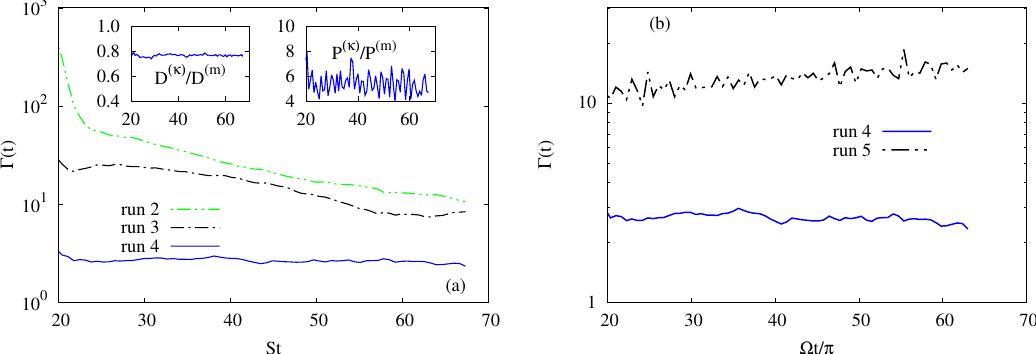
Figure 5. ( a ) Time development of Alfvén ratio Γ = E ( κ ) / E ( m ) in the PMHDT cases (runs 2–4) at the saturation stage. The left (respectively, right) inset shows the time development of the ratio D ( κ ) / D ( m ) (respectively, P ( κ ) / P ( m ) ) for the run 4. ( b ) Variation of the Alfvén ratio, Γ = E ( κ ) / E ( m ) , versus the dimensionless time Ω t / π in PMHTD case (run 4) and in RMHDT case (run 5). For both cases, the Elsasser number is about Λ =